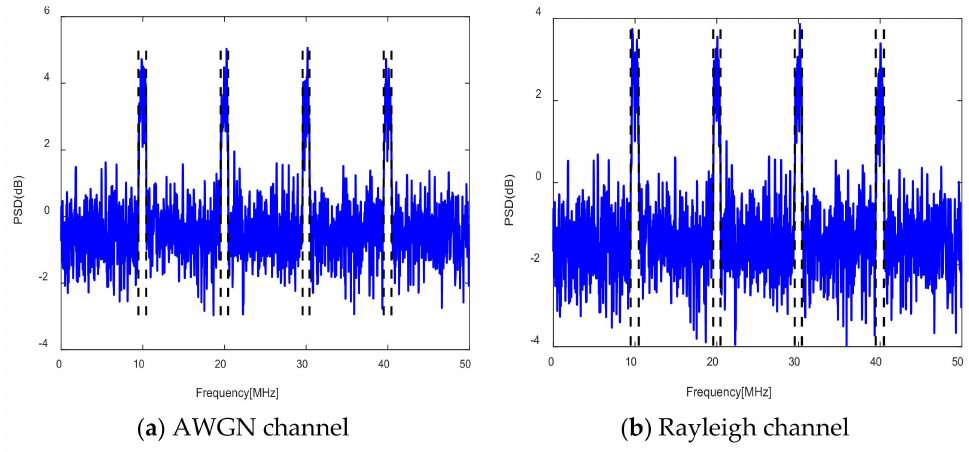
Figure 11. Proposed detection algorithm under different